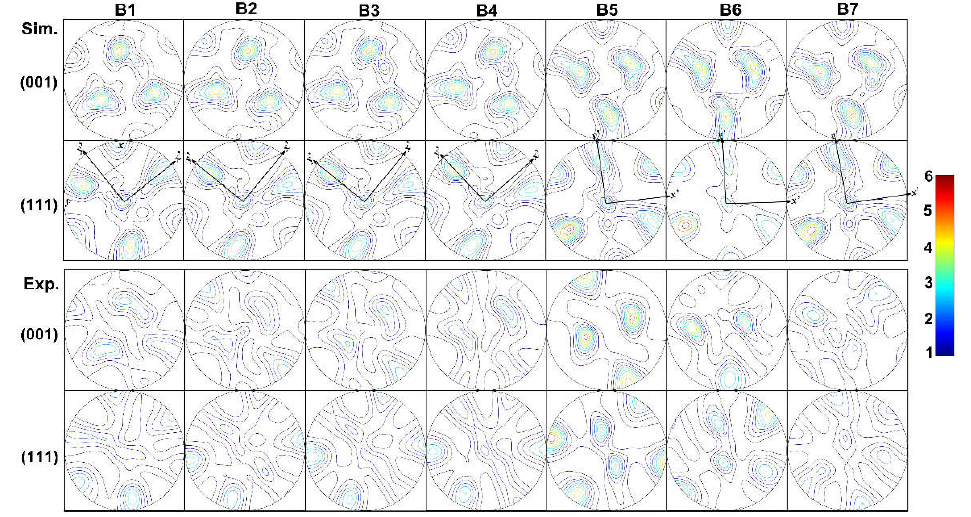
Figure 11. Experimental and Simulated {001} and {111} pole figures along the flow line B.